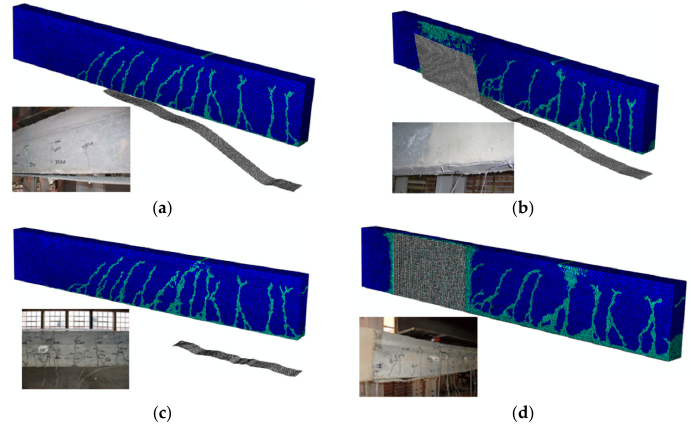
Figure 10. Numerical/Experimental failure mode: ( a ) Beam G1; ( b ) Beam G1-U; ( c ) Beam P1; ( d ) Beam P1-U.